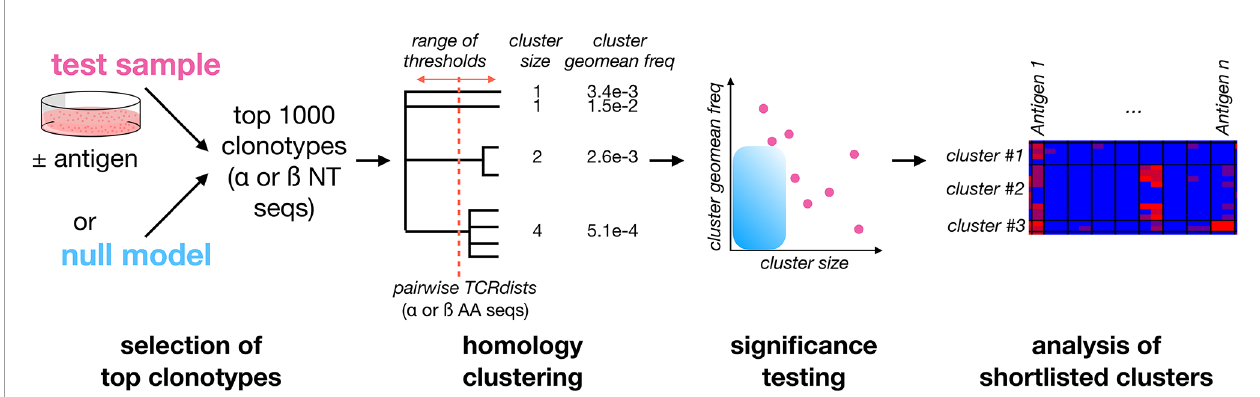
FIGURE 2 | A framework for identifying Clusters of Expanded TCRs (CETs) within complex repertoires. To identify antigen-responsive clonotypes admixed within a large population of irrelevant clonotypes, the 1000 most abundant TCR a or TCR b clonotypes for the sample of interest (resolved at the nucleotide level and quanti fi ed by deep sequencing) are analyzed by similarity-based clustering of their CDR amino acid sequences. Comprehensive pairwise similarity measurements using the TCRdist metric are used to identify clonotype clusters across a range of thresholds. The signi fi cance of each Cluster of Expanded TCRs (CET) is then quanti fi ed as the probability of observing a cluster with the same number of members, at or above its observed mean frequency, within trials of 1000 randomly- selected clonotypes. Finally, shortlisted clonotypes are analyzed for their abundance across multiple